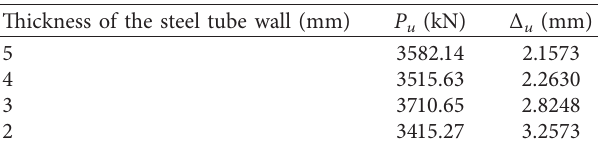
Table 5: Influence of steel wall thickness on ultimate axial bearing capacity and displacement of the specimen.